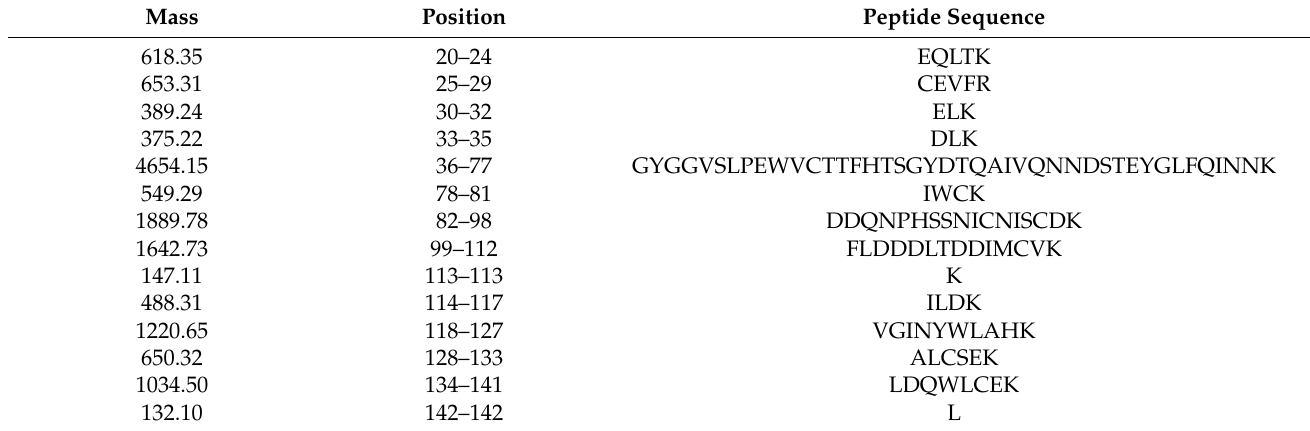
Table 2. Masses, positions in the protein and sequences of the calculated peptides after tryptic hydrolysis using the PeptideMass tool available at www.expasy.org (accessed on 20 March